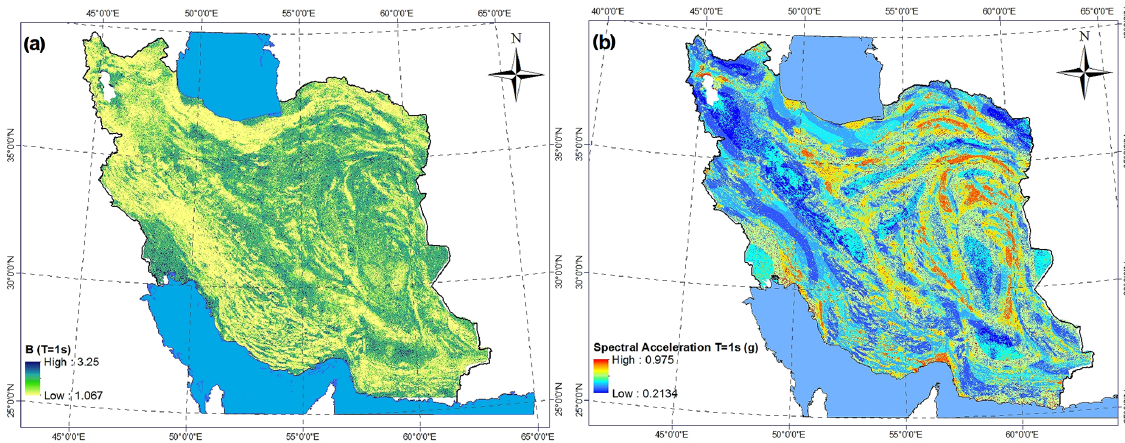
Figure 7. (a) Map of the reflection factor in 1s period, (b) map of the 1s spectral